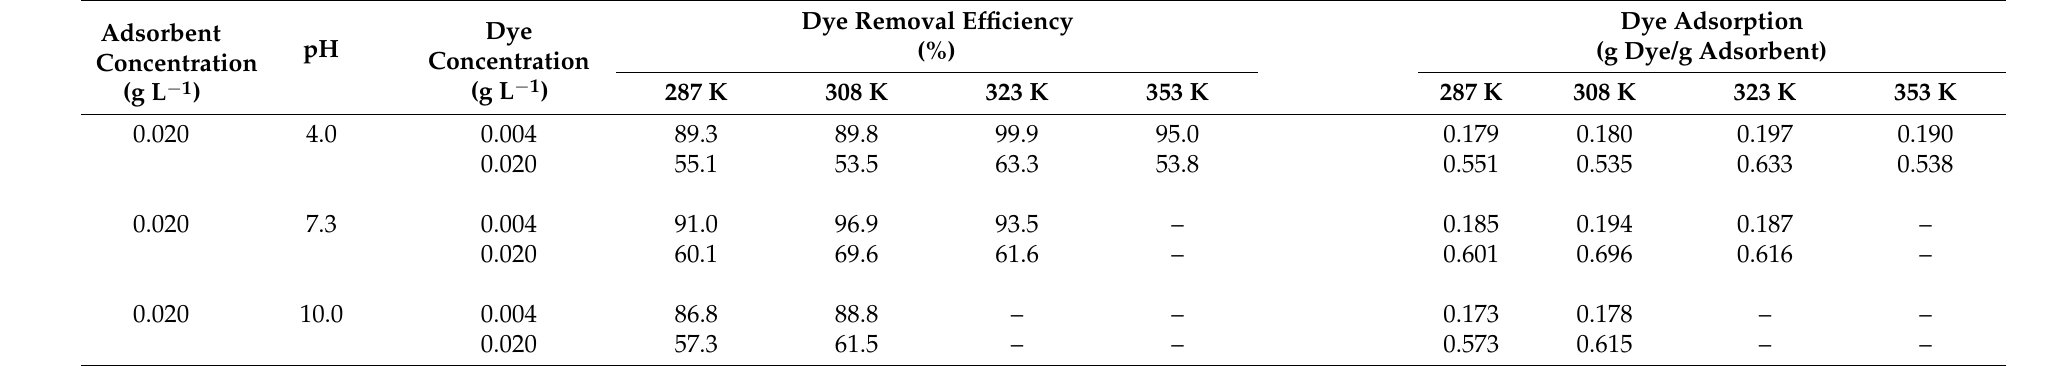
Table 1. Retention of BB 3 by potassium humate (experimental error ±